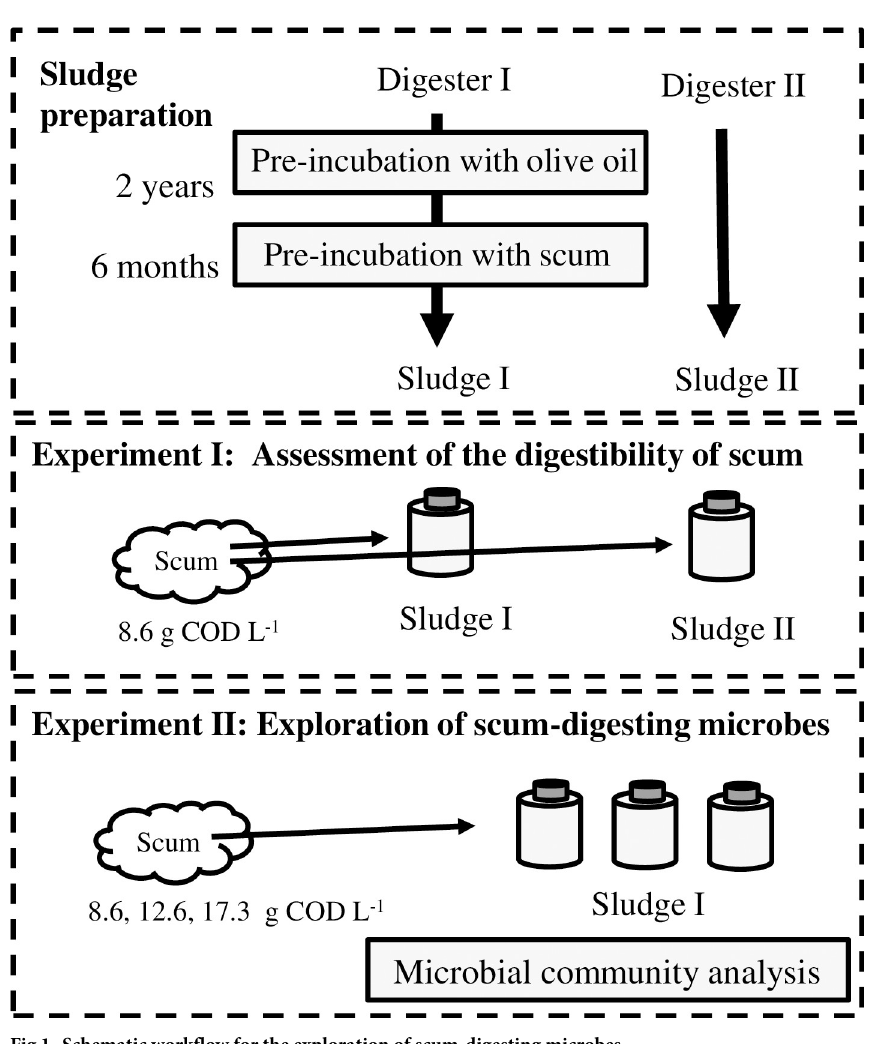
Fig 1. Schematic workflow for the exploration of scum-digesting microbes. manufacturer’s protocol. Methyl oleate, methyl stearate, and methyl palmitate were used as the standard mixtures, and the extraction efficiency was confirmed (R > 0.99). The TS and VS of 2 the sludge scum were measured by heating the samples at 100˚C and 600˚C overnight, respec- tively. The biogas volume was measured using a syringe, and the methane concentration was determined by gas chromatography (GC-8A; Shimadzu, Kyoto, Japan). The injection and detection temperatures were set to 100˚C and 120˚C, respectively. A packed column (Shincar- bon-ST; Restek, Bellefonte, PA, USA) was used, and a unit equipped with a thermal conductiv- ity detector was connected to an integrator (C-R8A; Shimadzu). Argon was used as the carrier gas. A modified Gompertz equation was applied to analyze methanogenesis performance quantitatively [14]. ð 1 Þ M(t) is the cumulative methane production at t (h), Mmax is the total amount of methane produced in time t, Rm is the maximum methane production rate, λ is the lag phase, t is the incubation time (d), and e is the exponential constant.